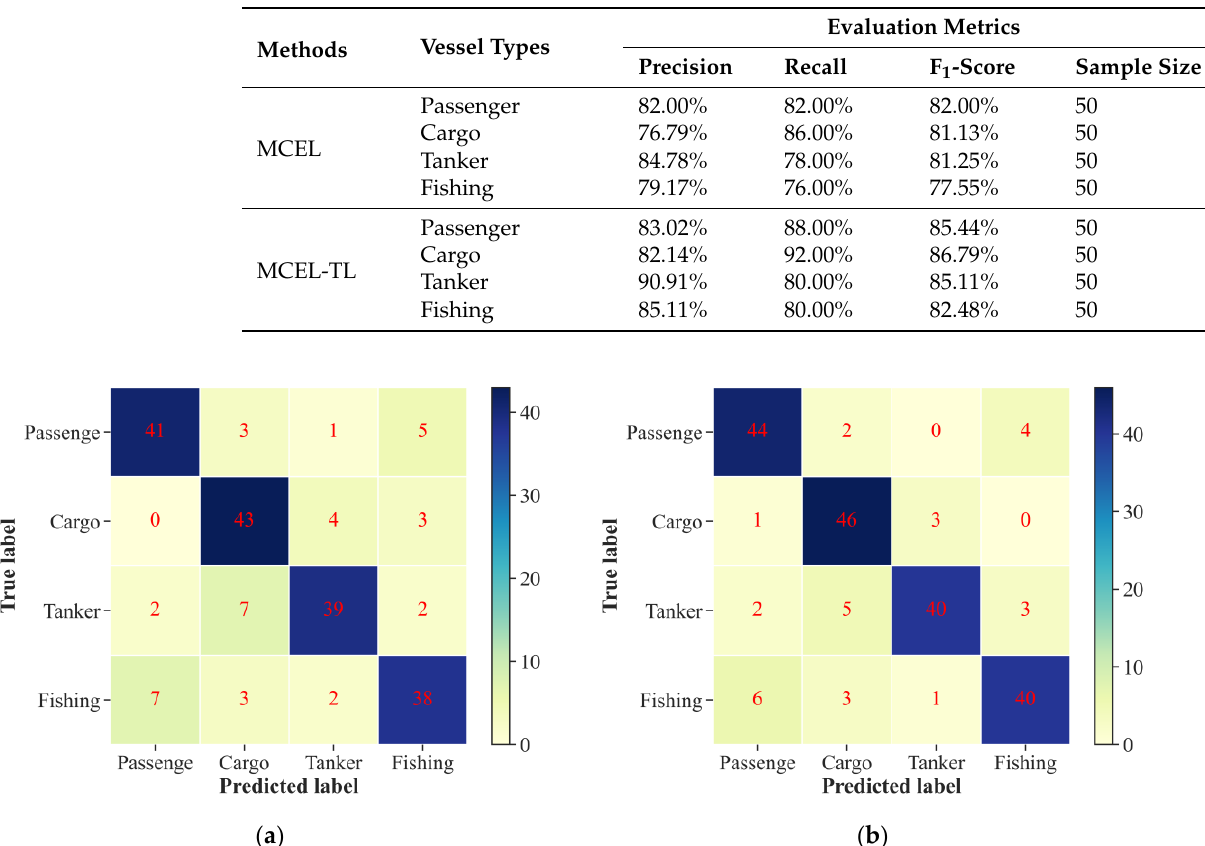
Table 6. The ship classification results of each classification method on the SAR test set with AIS data transfer.